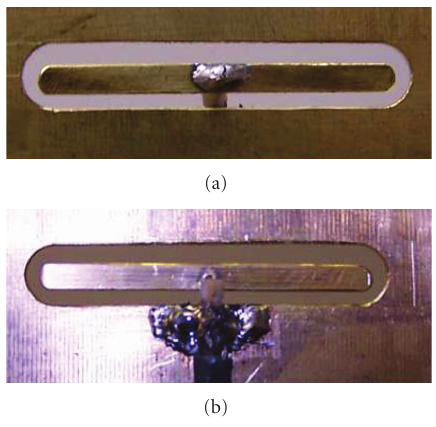
Figure 4: Resonance frequency of slot antenna versus ground plane size.